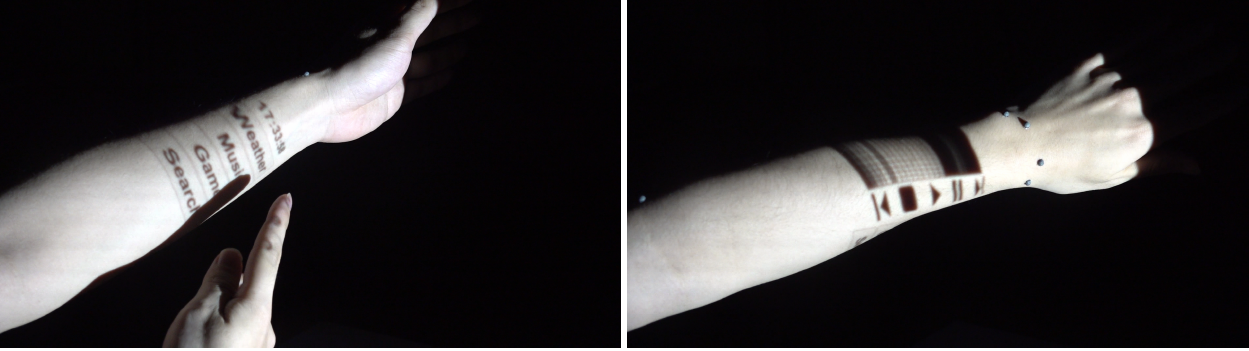
Figure 9. Both sides of the arm surface serving as on-body interfaces. The inner side of the arm serves as a menu panel ( left ), and the outer side serves as a music player interface ( right